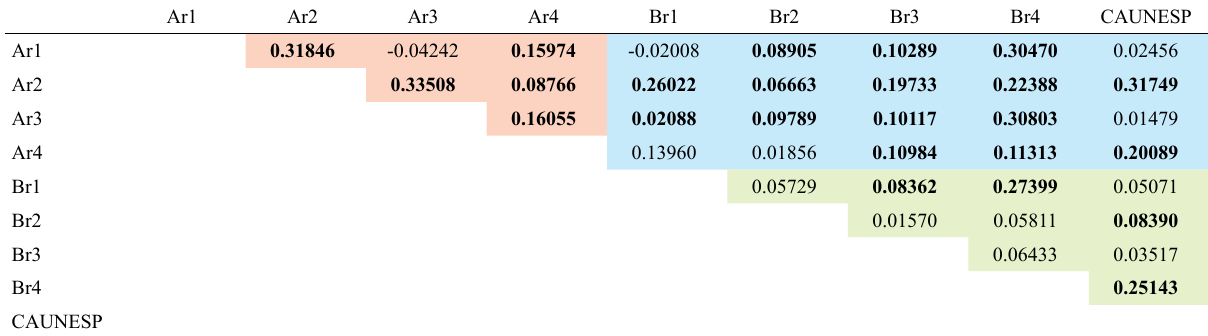
) between pairs of broodstocks of fish farms from Argentina, Brazil, and the breeding nucleus (CAUNESP) of Table 4 – Differentiation index ( F ST Piaractus mesopotamicus